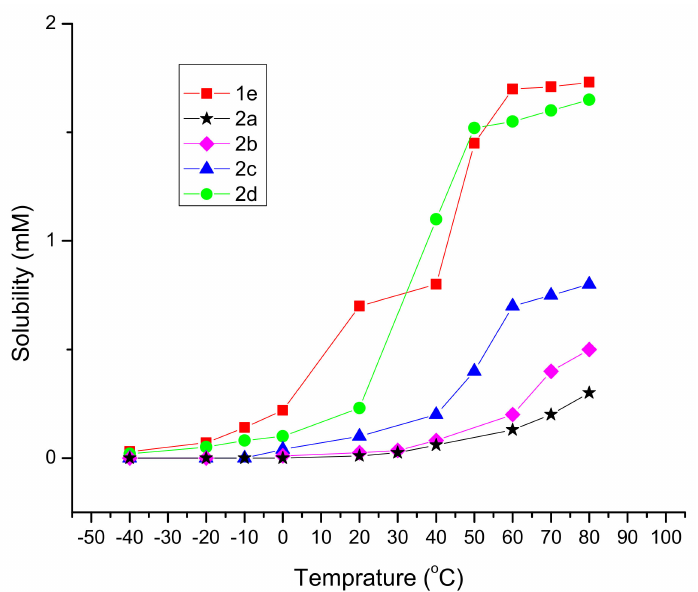
Figure 1. Solubility of Pd complexes 2a–d and ligand 1e in dimethylformamide (DMF) as a function of